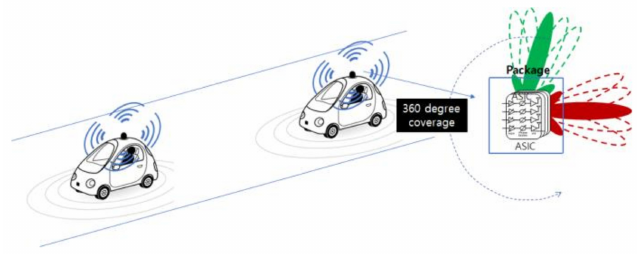
Figure 1. Proposed application.